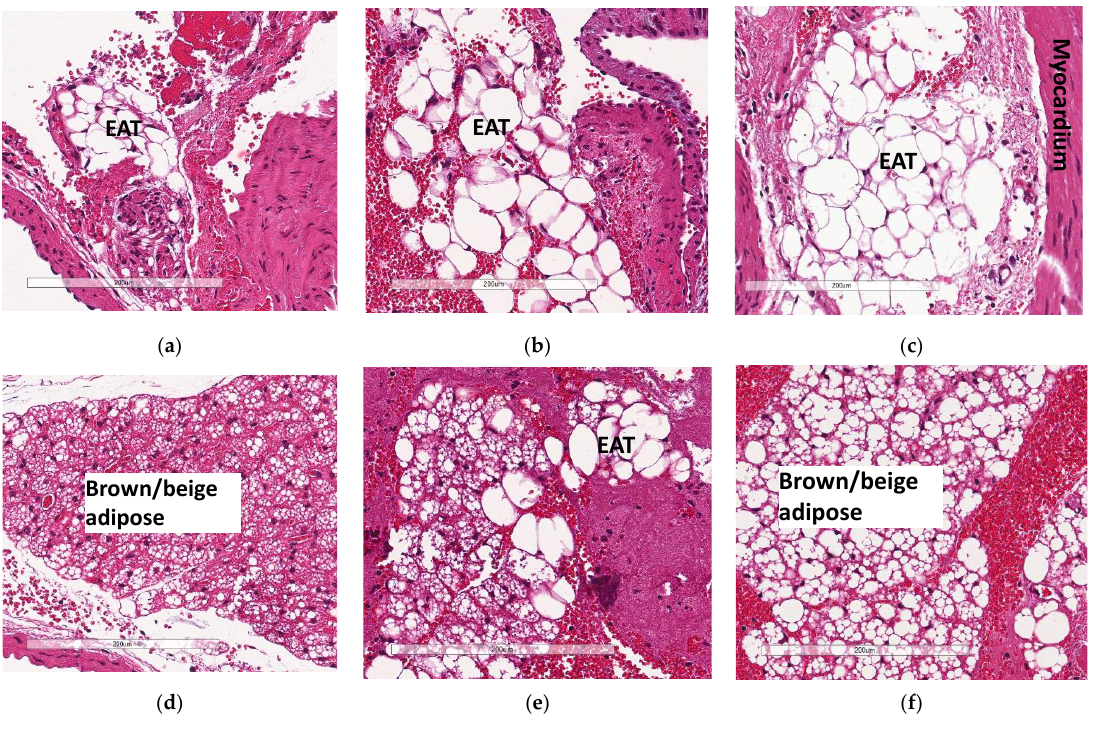
Figure 7. Effect of slc7a8 on epicardial adipose tissue accumulation in the heart. H&E-stained heart sections showed a greater accumulation of epicardial adipose tissue, seen as a brown/beige adipose depot, in the WTHFD ( c ) compared to WTCD ( a ) and KOHFD ( b ). The images demonstrate that the WTHFD ( f ) mice had more connective tissue (cardiac muscle fibres) than WTCD ( d ) and KOHFD ( e ). Magnification = 20 × . Scale bar = 200 µ